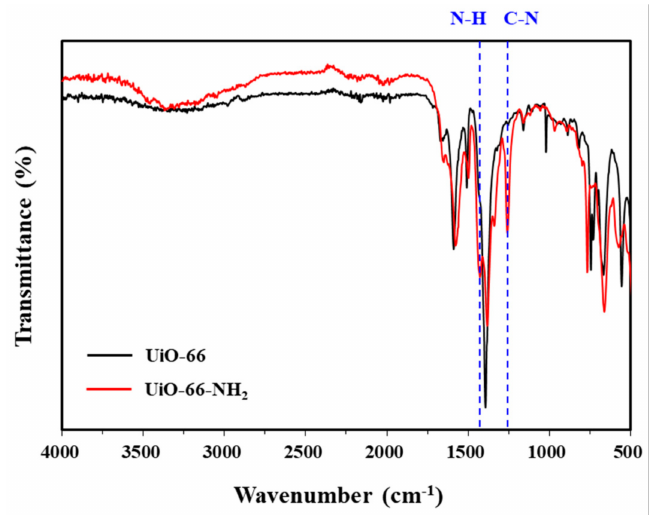
Figure 4. FT-IR spectra of UiO-66 and UiO-66-NH 2 before and after